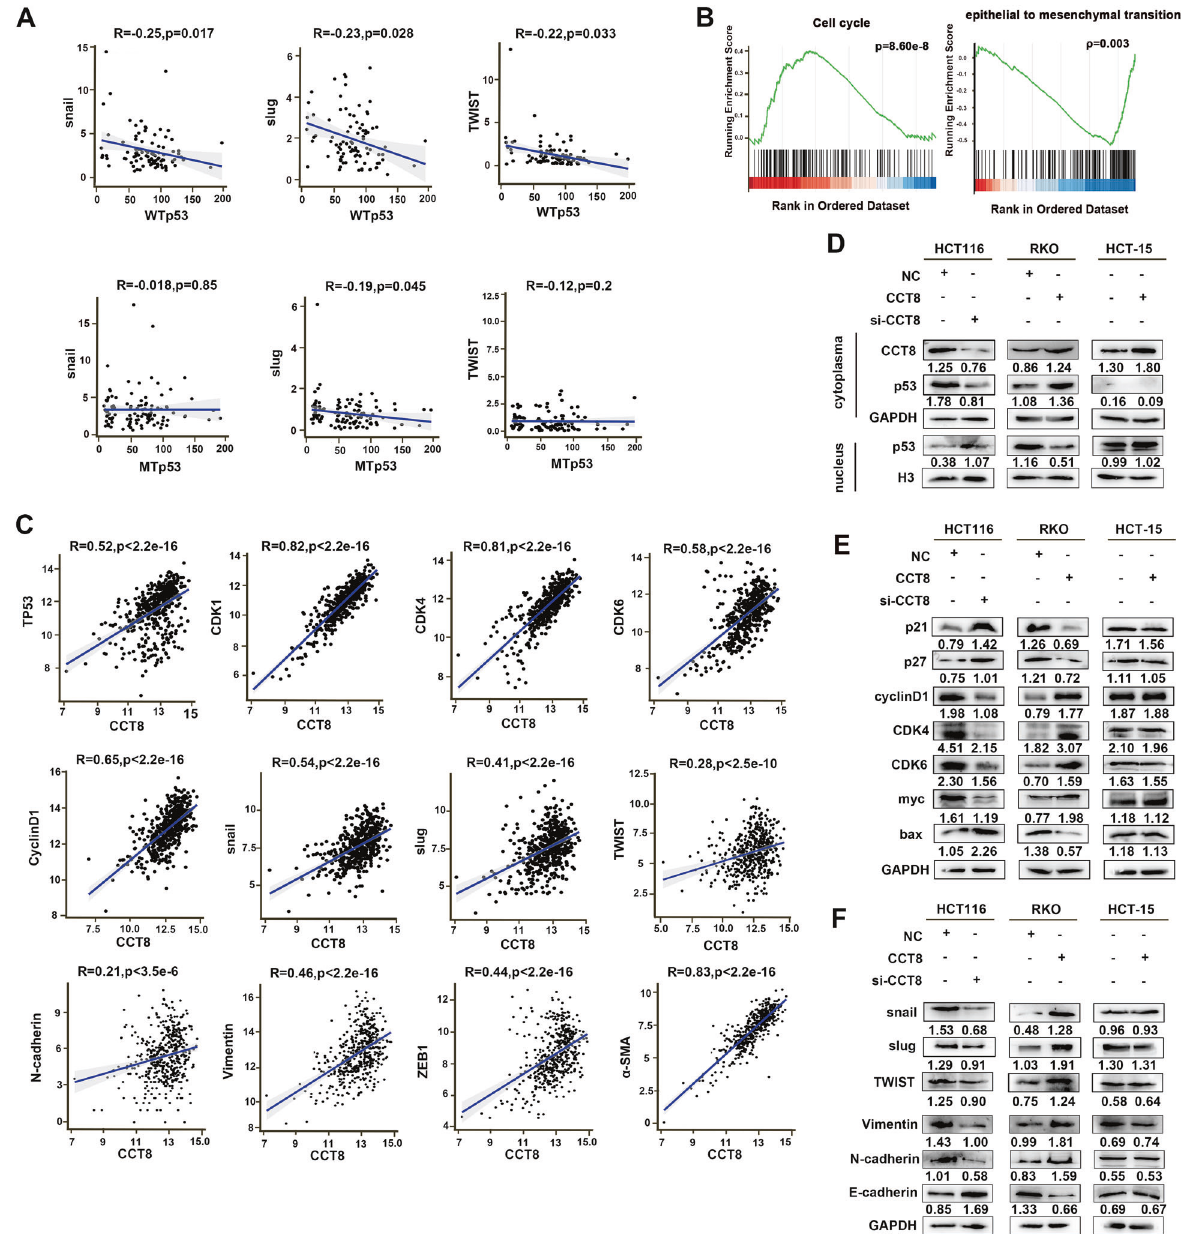
Fig. 5 CCT8 antagonizes WT p53 induced cell cycle arrest and EMT transcriptional inhibition. A The correlations between EMT transcription factors (snail, slug, and twist) and WTp53/MTp53. B GSEA demonstrated cell cycle and EMT transformation were closely related to the expression of CCT8. C The correlations between CCT8 and p53, cell cycle associated gene (CDK1, CDK4, CDK6, and CyclinD1) and EMT related markers (snail, slug, twist, N-cadherin, Vimentin, ZEB1 and α -SMA). D Effect of CCT8 on the expression of p53 were detected by Western Blotting analysis (a representative set of data was shown, n = 3). E , F Western Blot analysis was performed to detect the protein expression of cell cycle pathway and epithelial-mesenchymal transition